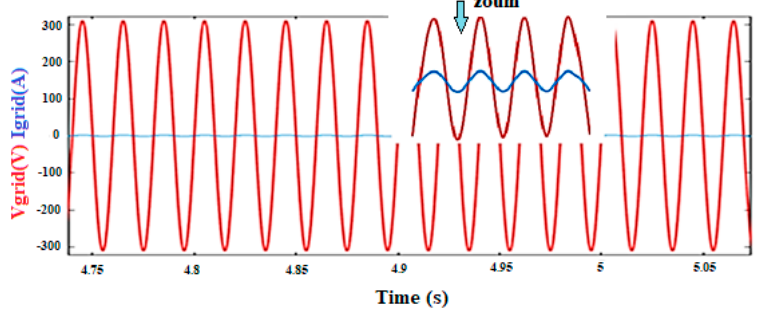
Figure 16. The voltage–current fed into the grid.